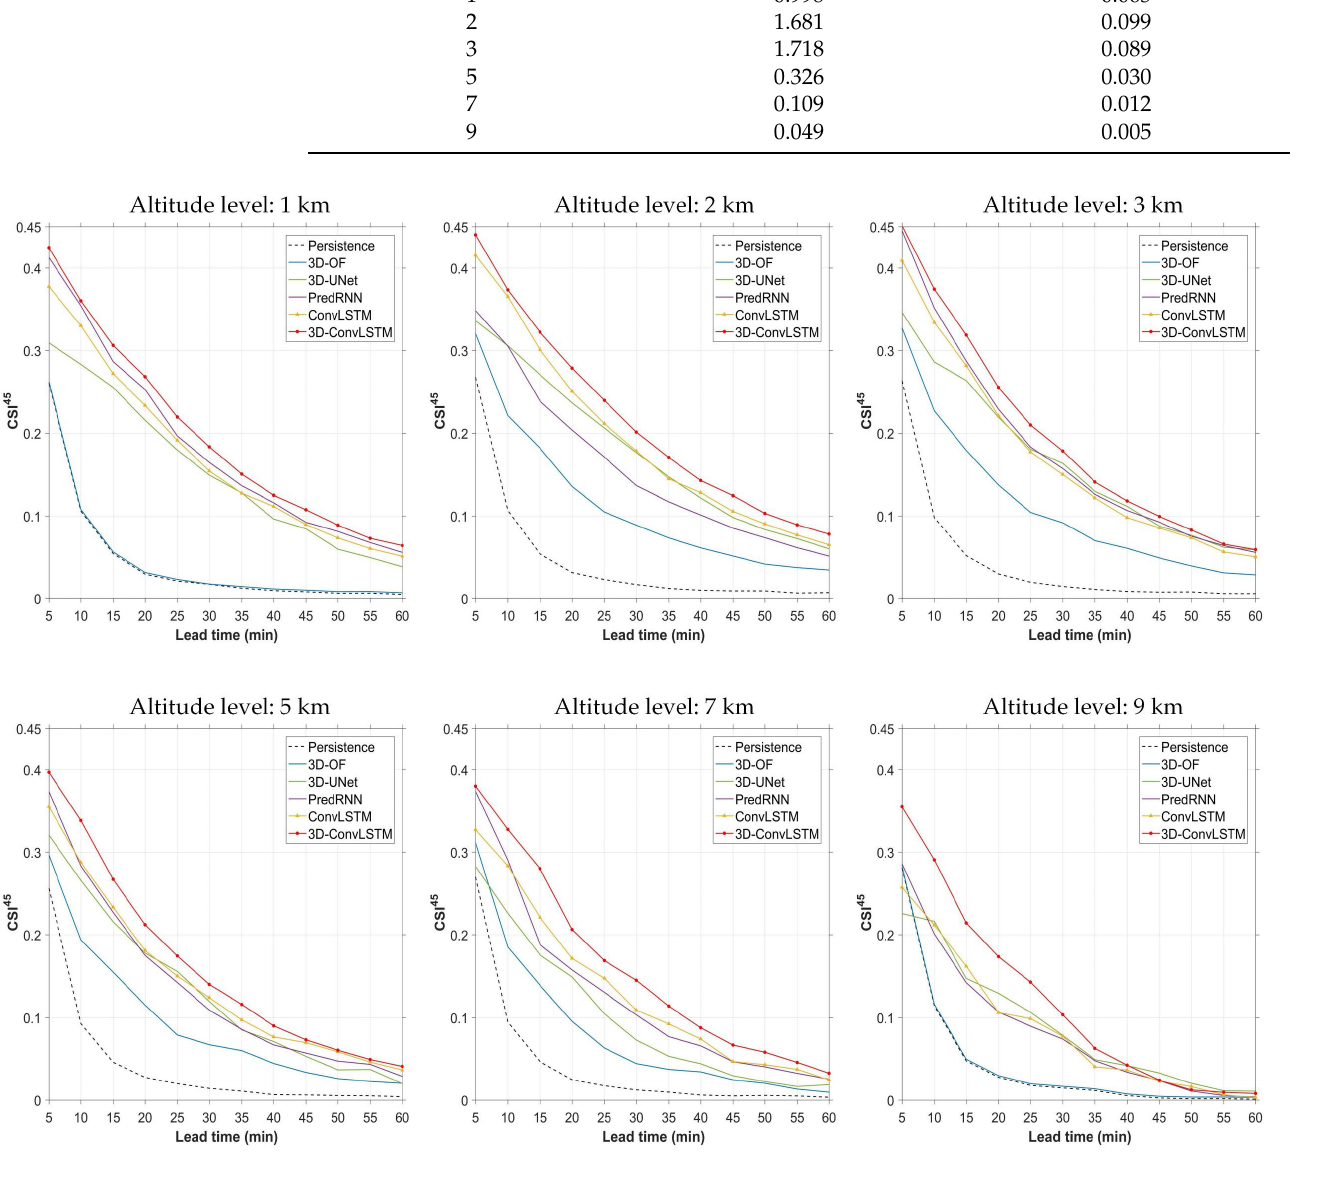
Figure 6. CSI curves of the compared 3D REE models at 45 dBZ for six different altitude levels (1, 2, 3, 5, 7, and 9 km). 3, 5, 7, and 9